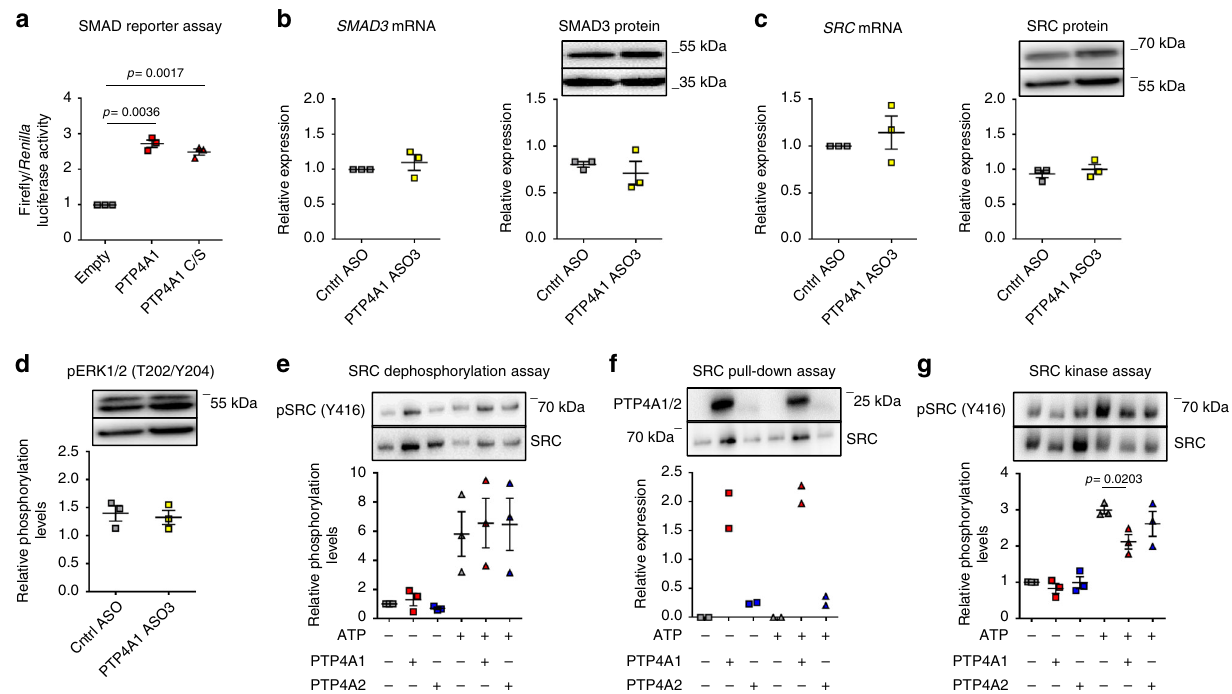
Fig. 7 PTP4A1 inhibits the basal autophosphorylation of SRC. a Mean ± SEM of relative ratio of fi re fl y/ Renilla luciferase signal of HEK 293T cells co-transfected with human HA-tagged PTP4A1 WT or PTP4A1 C104S (phosphatase dead)-encoding pCDNA4 vector together with a fi re fl y luciferase SMAD reporter and a control Renilla luciferase vector. Cells were stimulated with TGF β 1. Graph is representative of three independent experiments. b – d Mean ± SEM of SMAD3 or SRC mRNA expression or densitometric scan relative expression plus representative immunoblotting for SMAD3, SRC, pERK1/2 (T202/Y204) (upper bands) normalized to GAPDH or α tubulin (lower bands) in three different NHDF lines treated with control ASO or PTP4A1 ASO3. e Mean ± SEM of densitometric scan expression plus representative immunoblotting for pSRC (Y416) (upper bands) normalized to SRC (lower bands) in three different in vitro SRC kinase assay followed by incubation with PTP4A1/PTP4A2. f Densitometric scan expression plus representative immunoblotting for PTP4A1/2 (upper bands) normalized to SRC (lower bands) in two different in vitro SRC pull-down assay in presence of PTP4A1 or PTP4A2. g Mean ± SEM of densitometric scan expression plus representative immunoblotting for pSRC (Y416) (upper bands) normalized to SRC (lower bands) in three different in vitro SRC kinase assay carried out in presence of PTP4A1/PTP4A2. Paired t